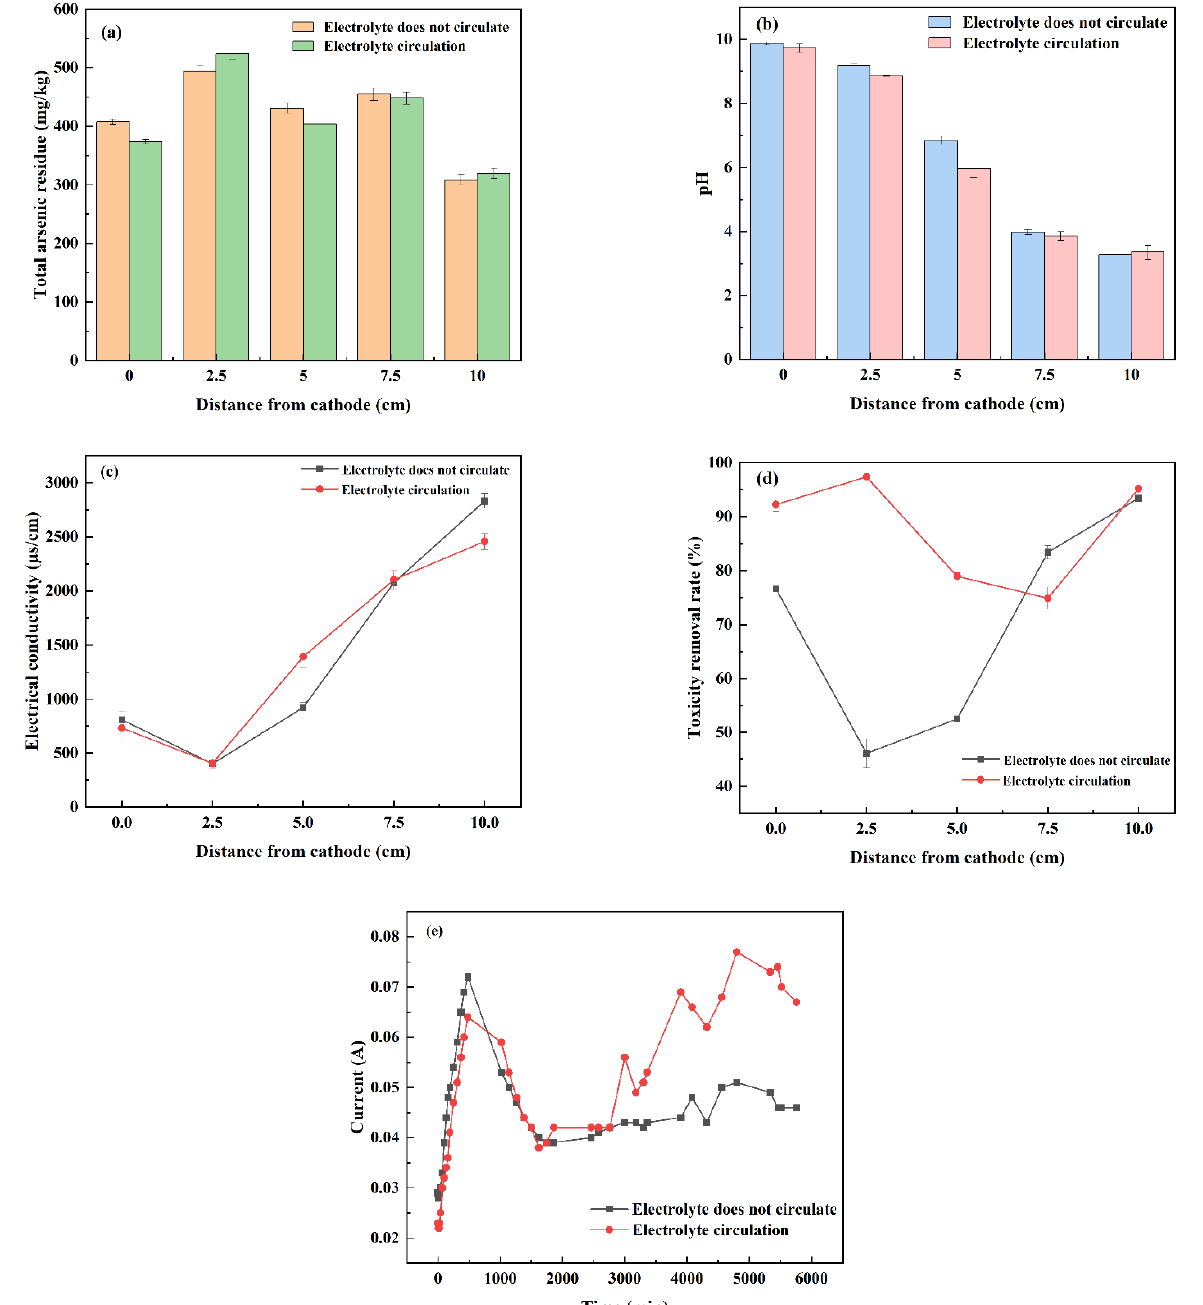
Figure 5. Effect of circulating/non-circulating electrolyte on polarization phenomenon for the remediation of arsenic-contaminated soil by EK-PRB. Total arsenic residue ( a ), pH ( b ), electrical conductivity ( c ), toxicity removal rate ( d ) and current ( e ).